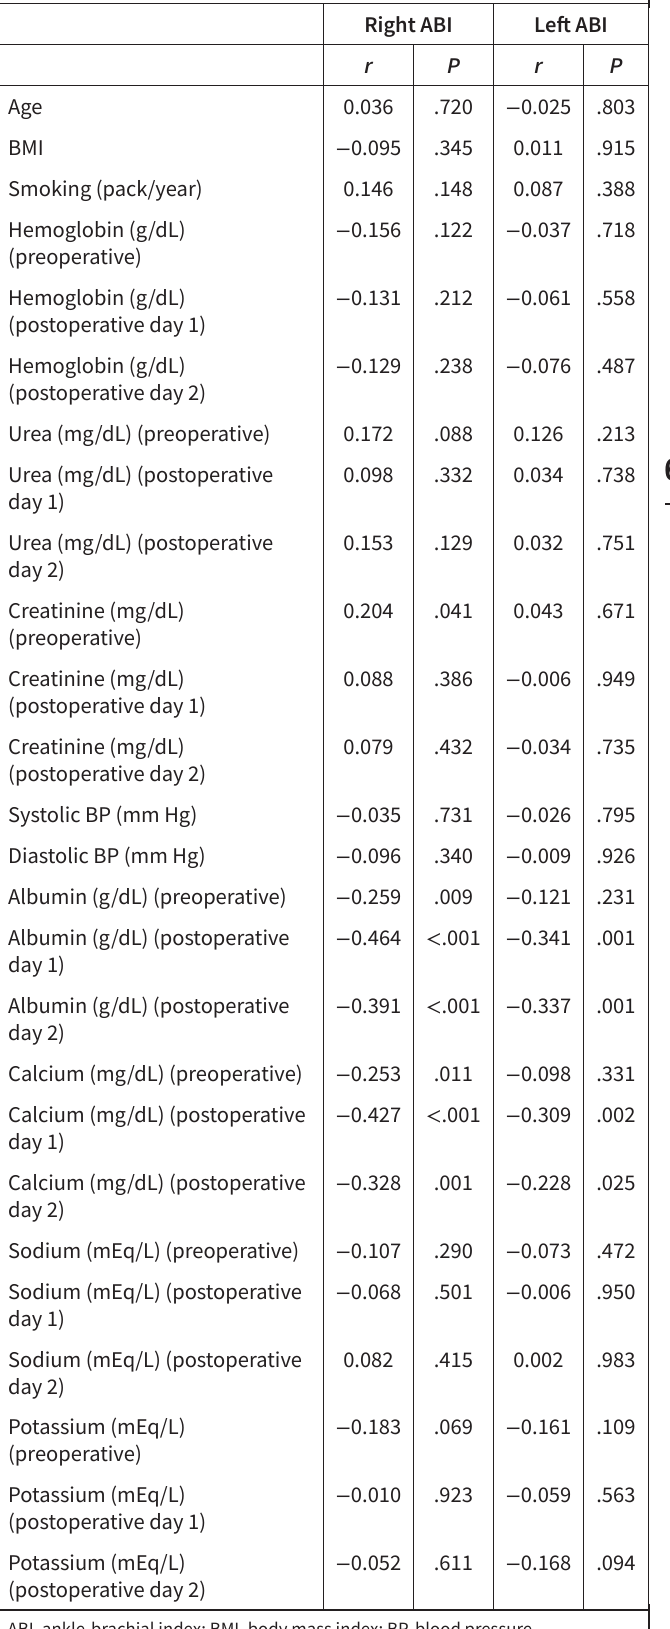
Table 2. The Characteristics of Patients According to the Development of